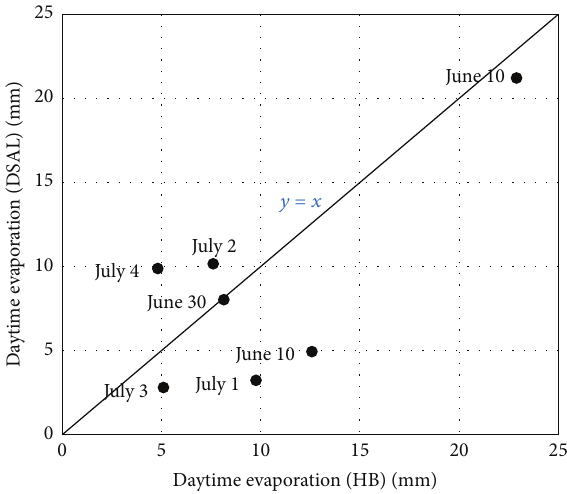
Figure 11: Comparison of the daytime evaporation instances obtained by the heat balance (HB) method and those obtained by the aerodynamic method based on the DSAL model (DSAL)